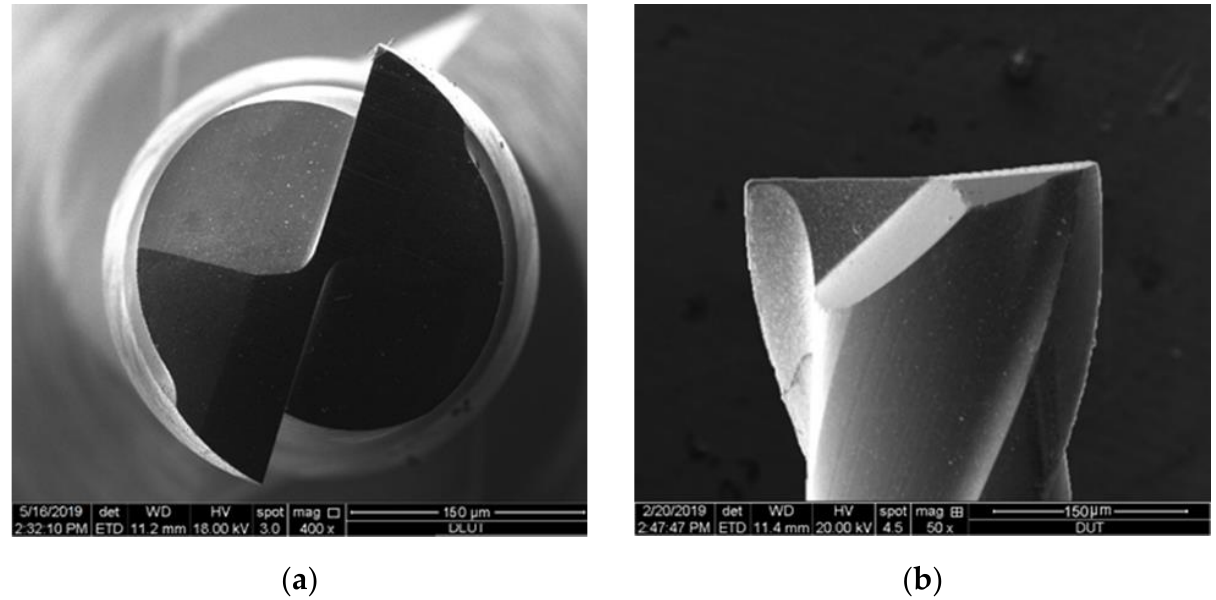
Figure 1. SEM images of the micro-milling tool. ( a ) End face ; ( b ) side.